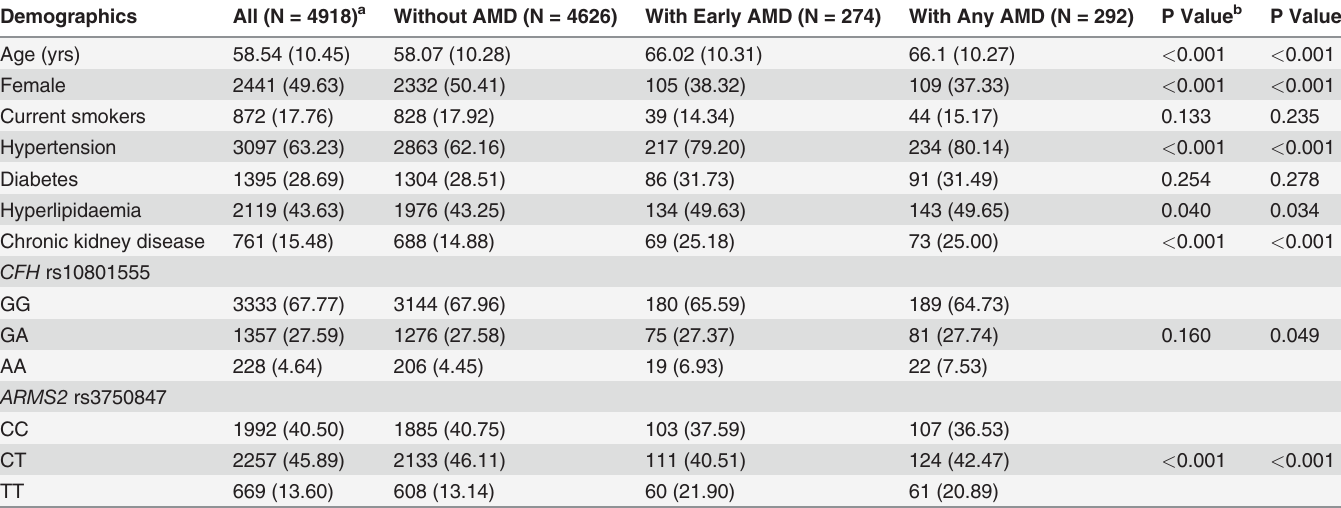
Table 1. Characteristics of subjects without AMD, with early AMD and with any AMD.